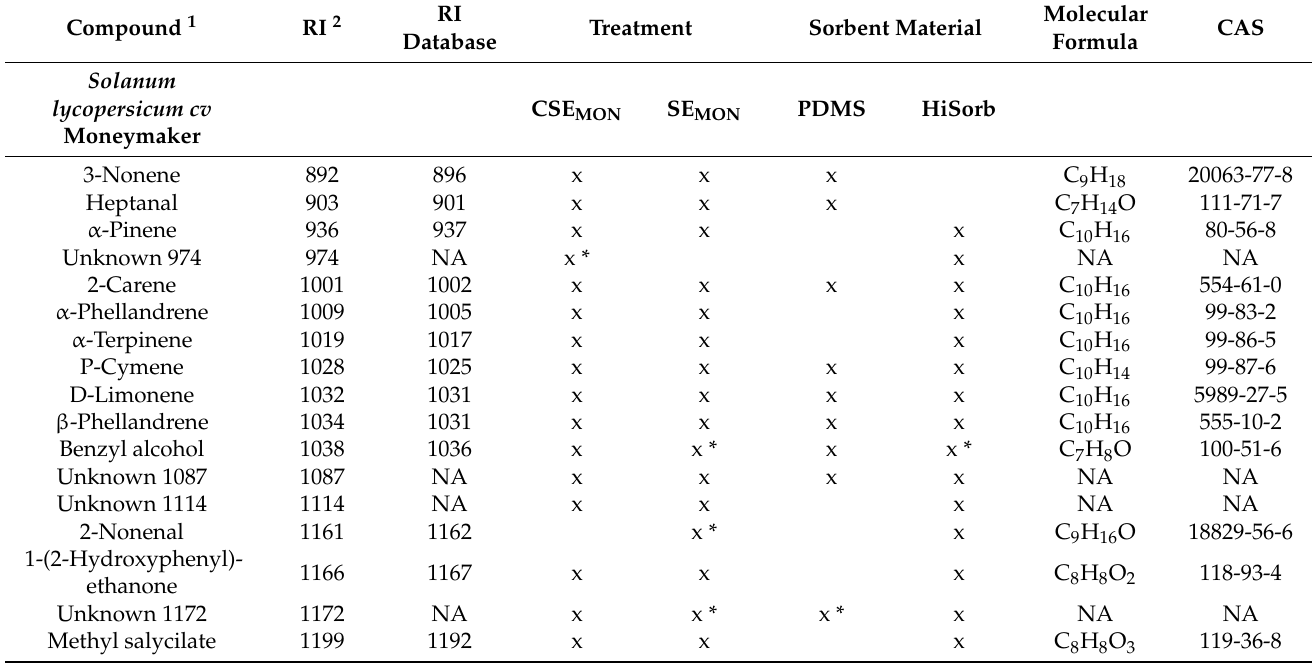
Table 1. List of root volatile compounds identified in S. lycopersicum cv Moneymaker in stressed (SE MON ) and non-stressed (CSE MON ) plants detected with PDMS and HiSorb. Compounds marked with an asterisk (*) in the Treatment column were uniquely detected in the stressed (SE) or non- stressed (CSE) treatments with the indicated trapping